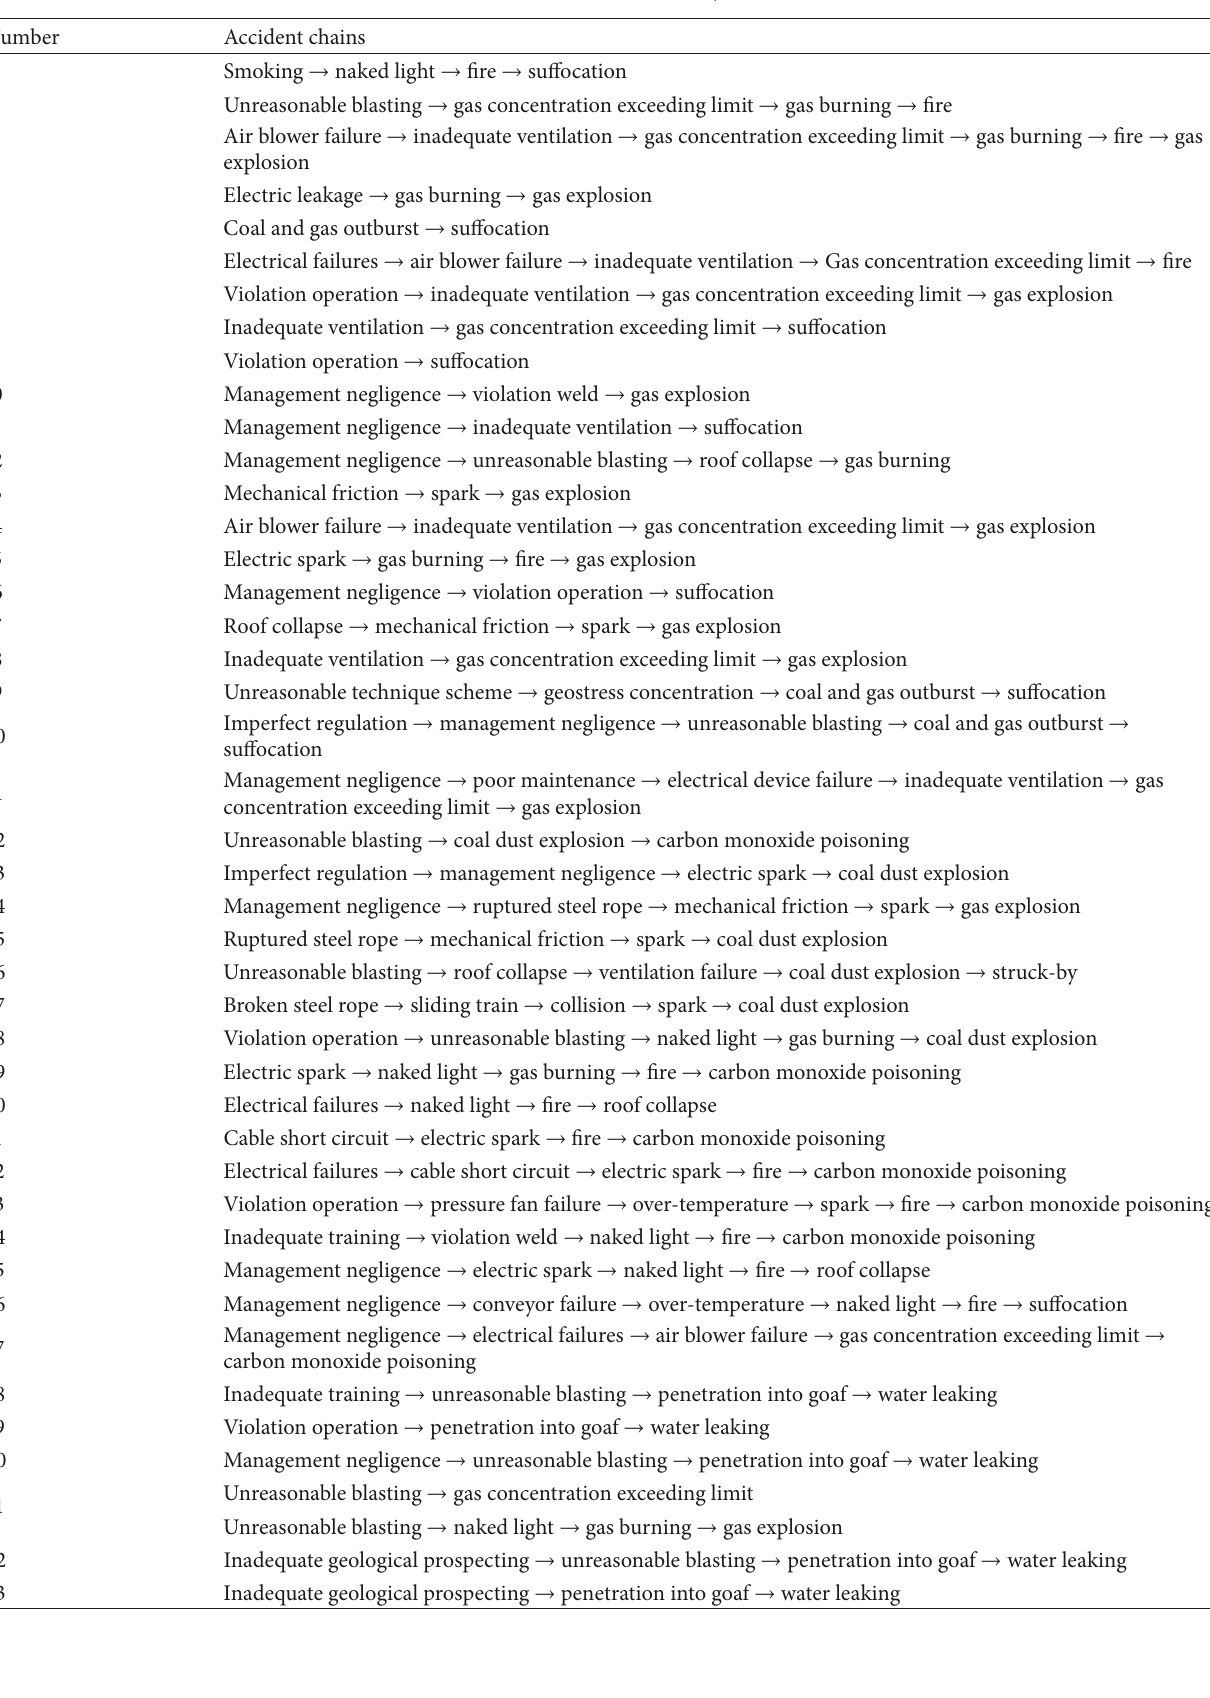
Table 3: Accident chain